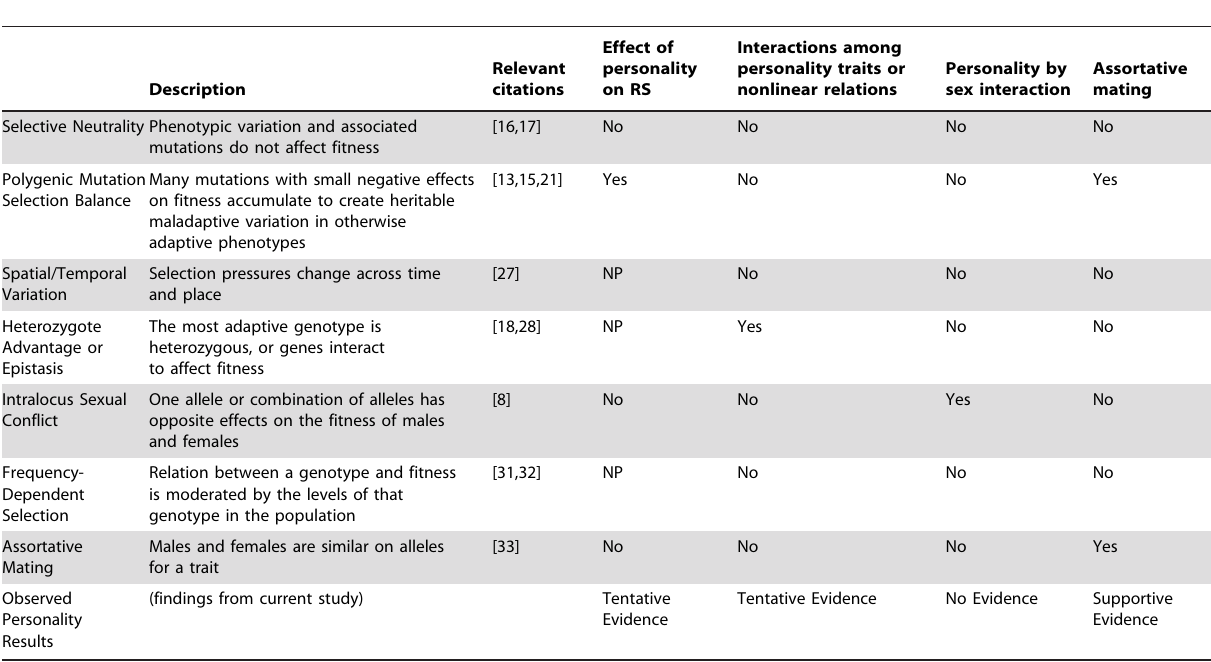
Table 1. Descriptions and Predictions by Hypothesis and Actual